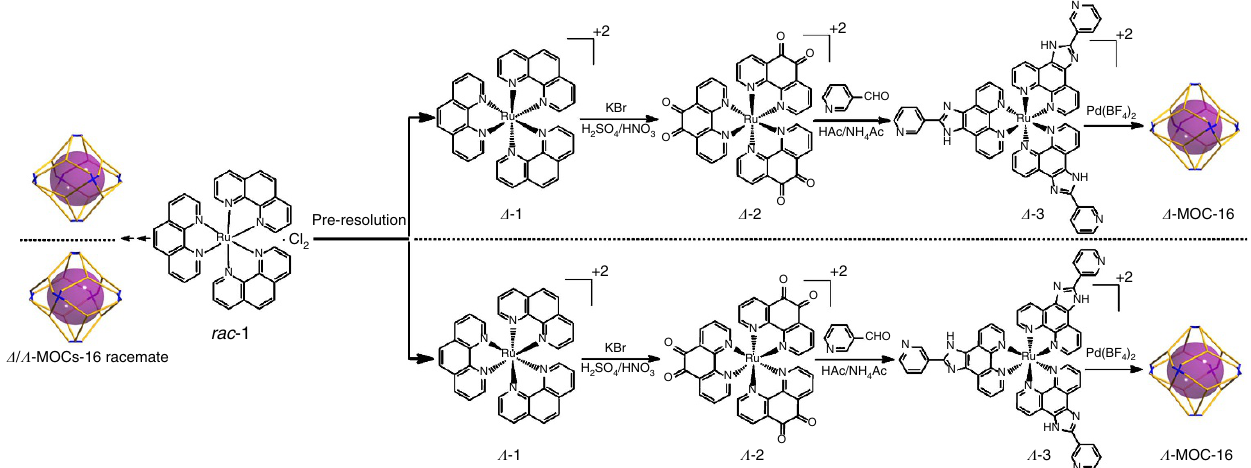
Figure 1 | Assembly procedures. Formation of racemic D / L -Pd 6 (RuL 3 ) 8 cages ( rac - D / L -MOCs-16) from mixed precursors, and stepwise syntheses of enantiopure D - and L -Pd 6 (RuL 3 ) 8 cages ( D -/ L -MOCs-16) from pre-resolved D - 3 and L -3 metalloligands. NATURE COMMUNICATIONS|7:10487|DOI: